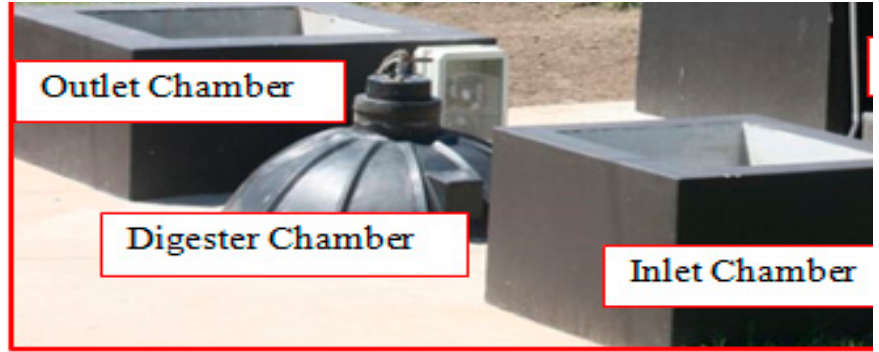
Figure 2. The biogas digester.